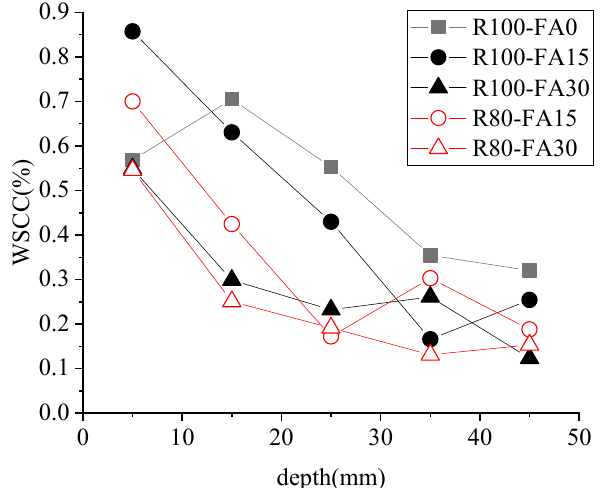
Figure 9. WSCC of concrete samples after 3%NS-45FT.